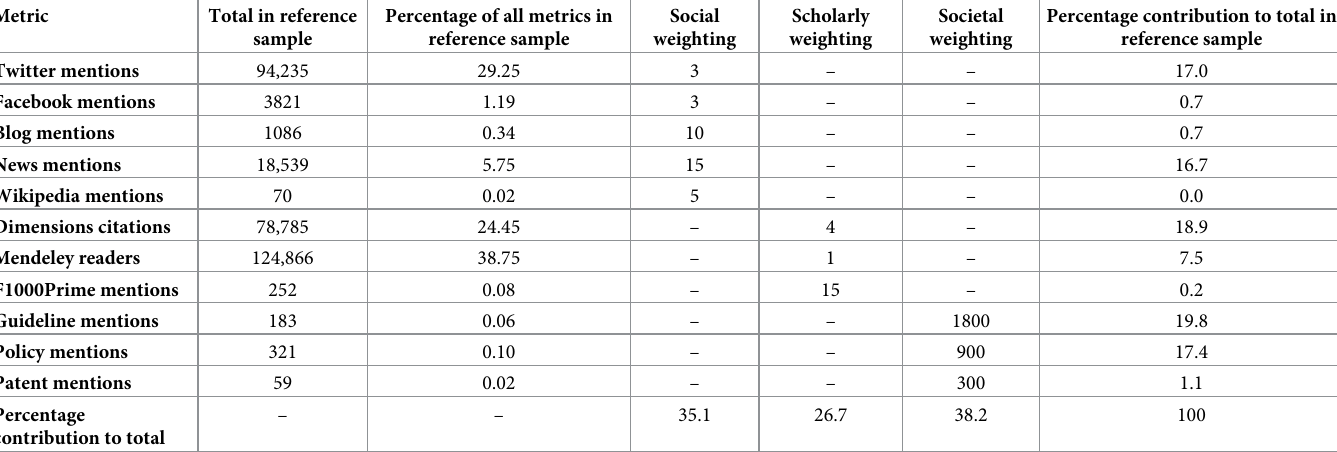
Table 2. Weighting assigned to metrics included in the social, scholarly, and societal impact scores, along with their contribution to total impact scores in the refer- ence sample.